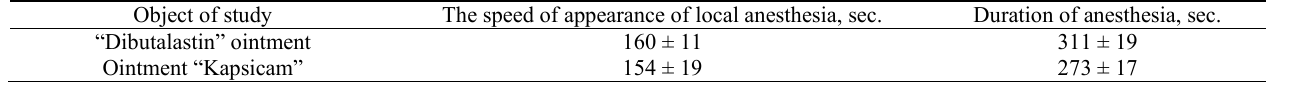
The effect of the ointment on the anesthesia of the rabbit eye (М ± m, n = 5) Object of study The speed of appearance of local anesthesia, sec. Duration of anesthesia, sec. “Dibutalastin”